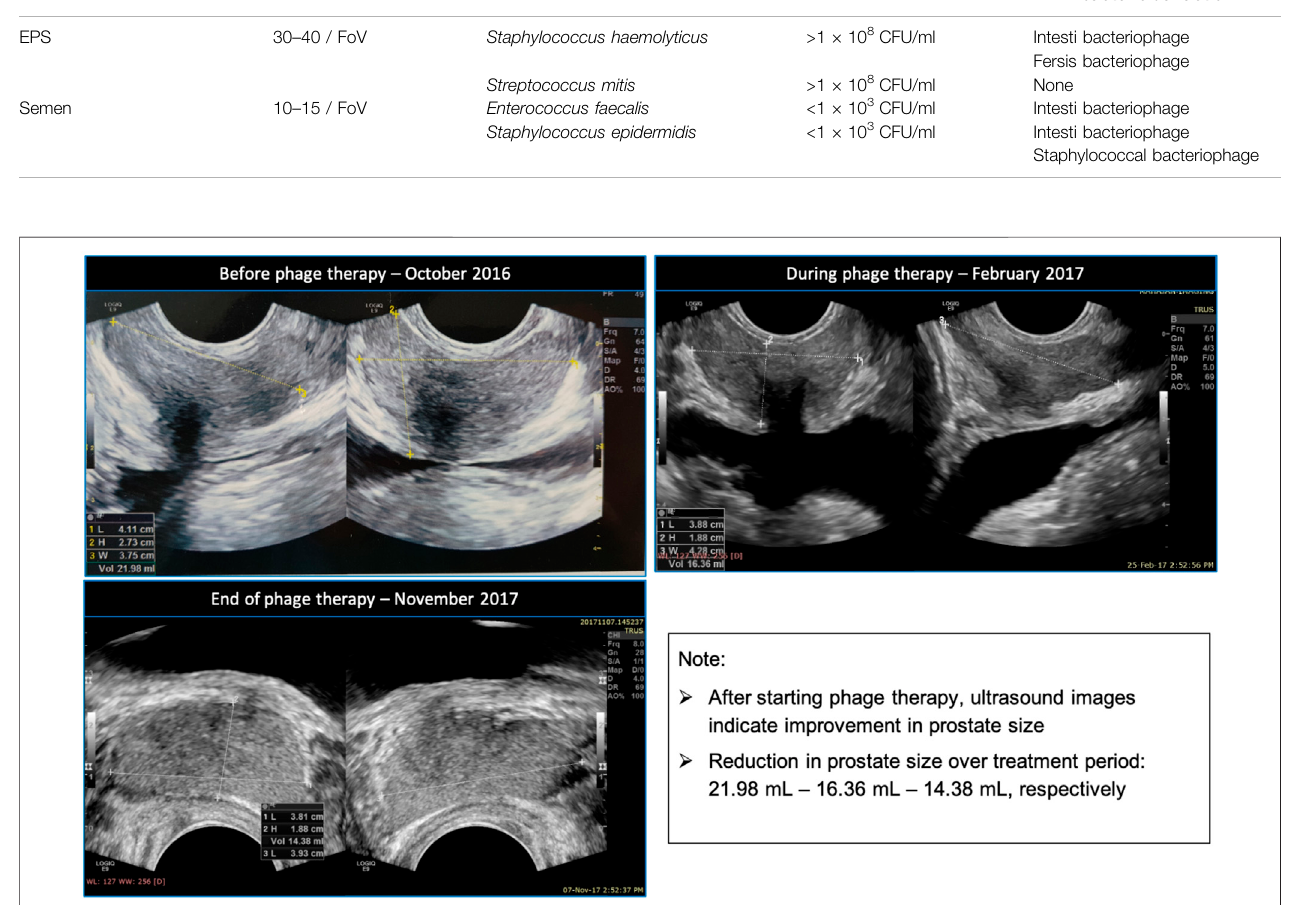
FIGURE 1 | Clockwise ultrasound images of the patient ’ s prostate before, during and towards the end of his phage therapy.